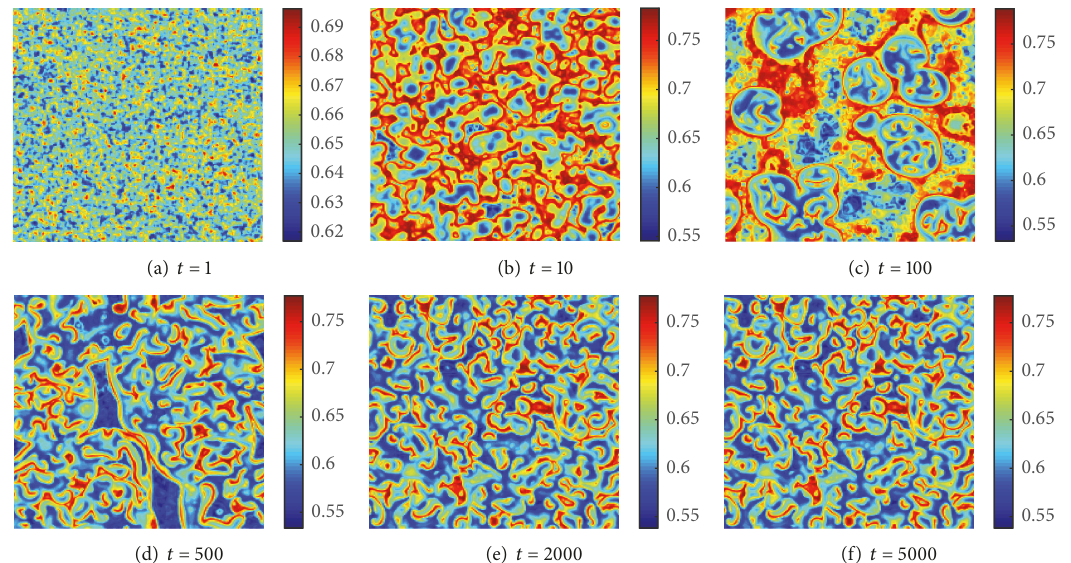
Figure 5: Pattern formation resulting from spatially symmetry breaking on chaotic attractor and starting with stochastic initial condition. 𝑎 = 1.63, 𝑏 = 0.1, 𝑐 = 0.32, 𝑑 = 0.22, 𝐷 1 = 0.6, 𝐷 2 = 1.2, 𝜏 = 5.83, 𝛿 = 10, and 𝑛 = 200.